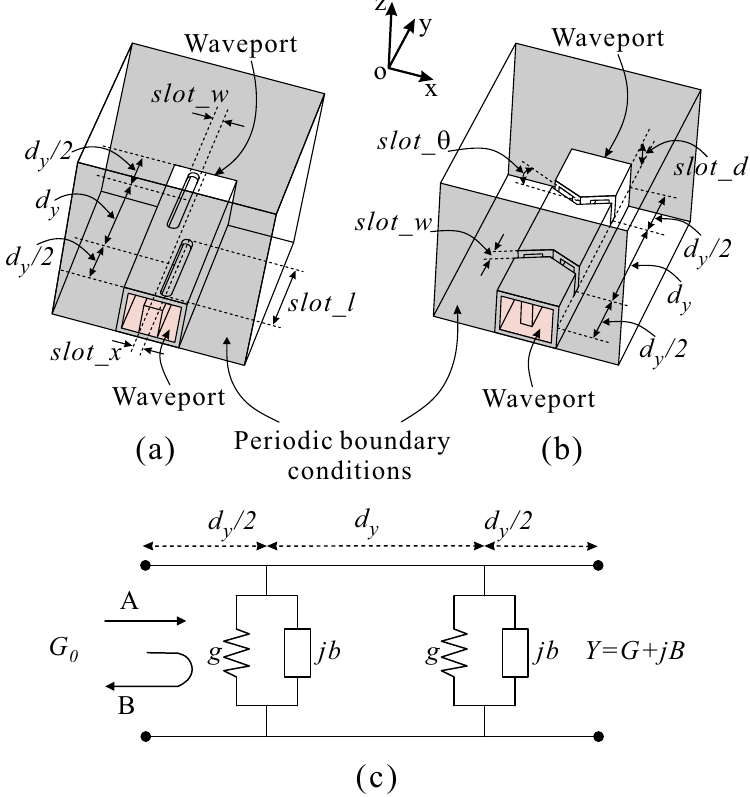
Figure 4. Unit cell characterization of the two-port two-slot module. ( a ) VP slotted RWG. ( b ) HP slotted RWG. ( c ) Equivalent circuit of the resonant